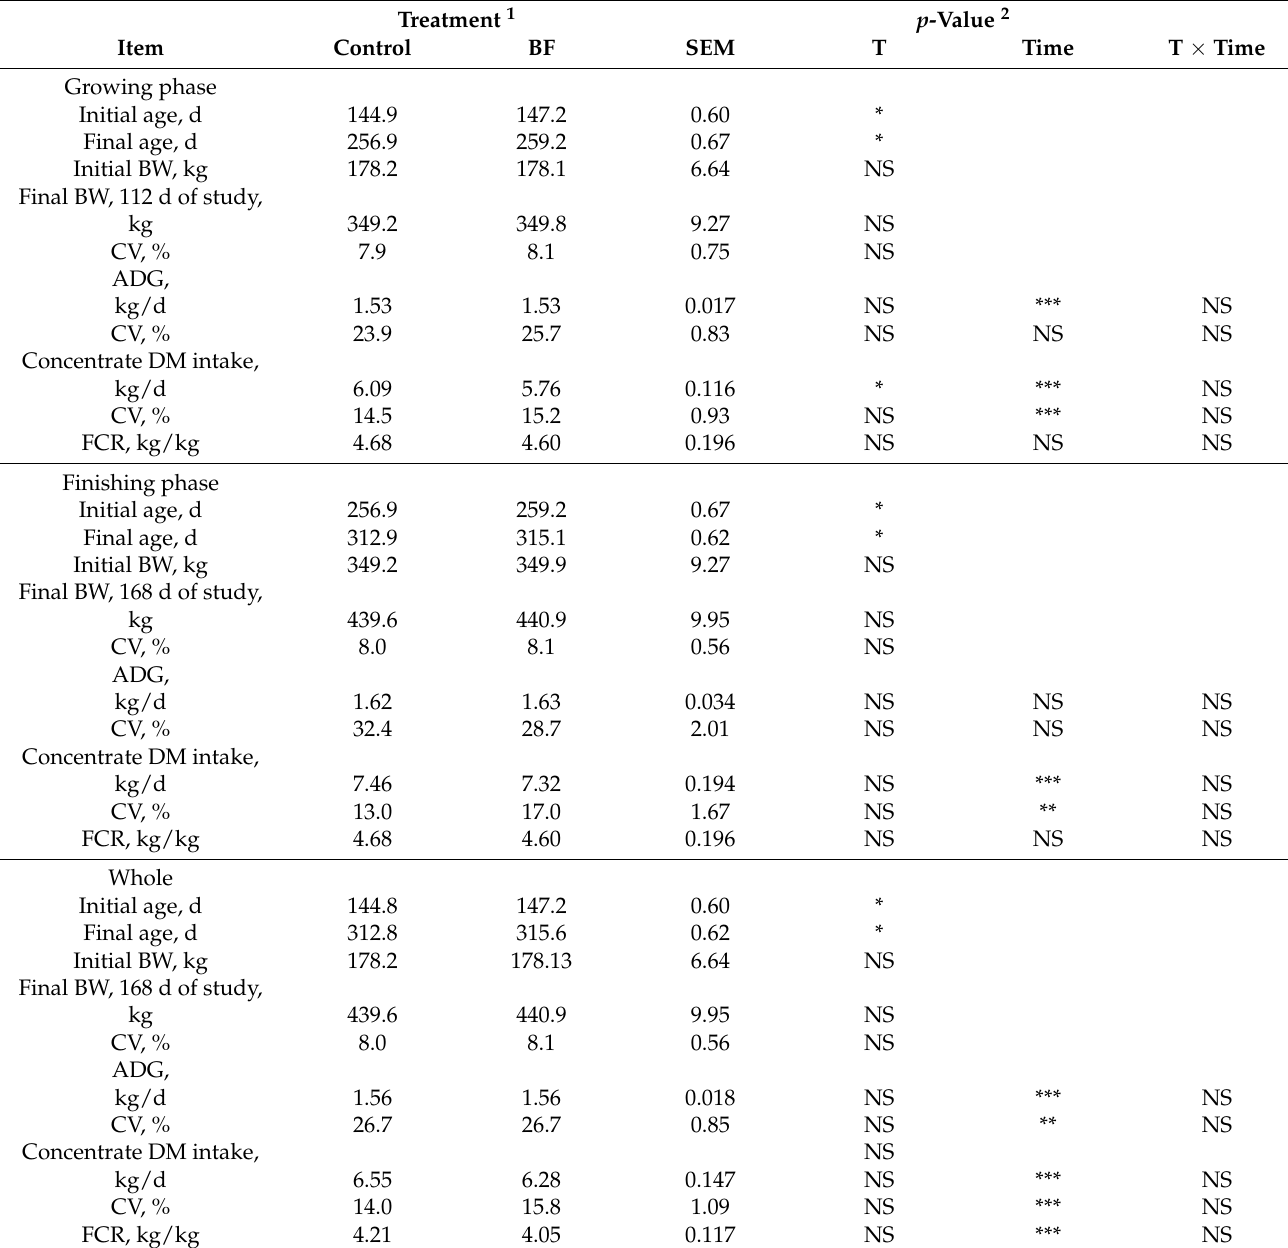
Table 2. Performance and concentrate intake for growing and finishing phase, and for the whole study in Holstein bulls fed high-concentrate diets supplemented with citrus